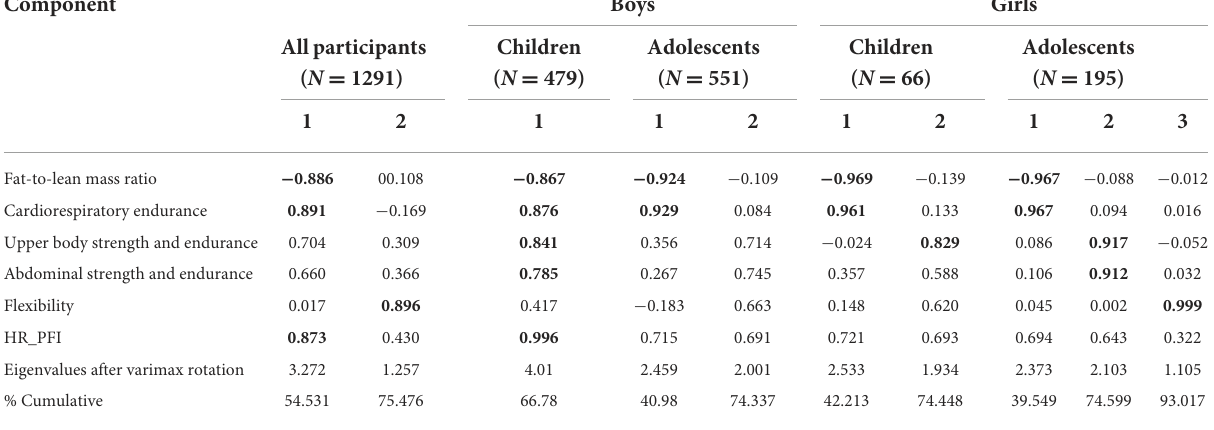
TABLE 6 Factors extracted, eigenvalues and proportion of variance after rotation. Component